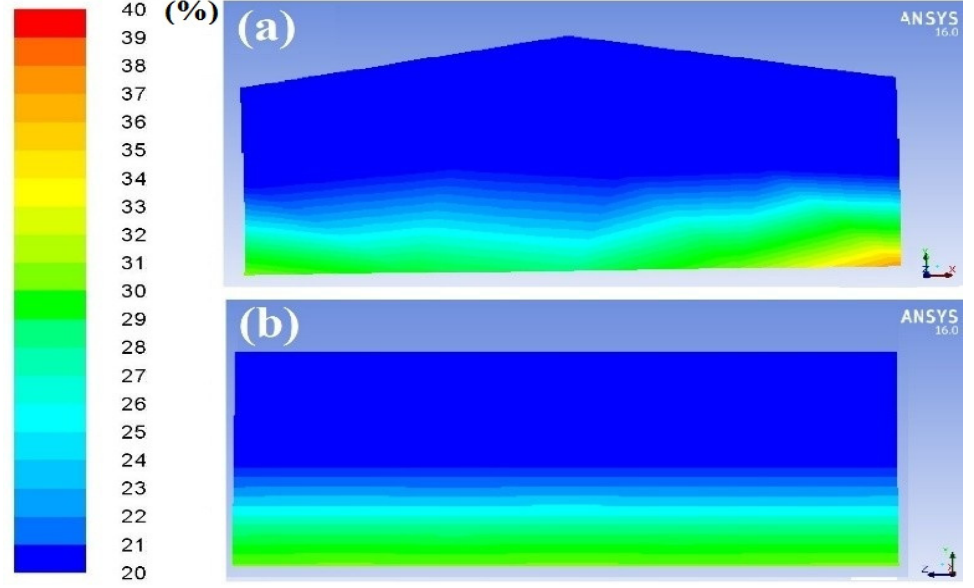
Figure 12. Relative air humidity contour (%) at the center of the greenhouse: vertical section ( a ) and horizontal section ( b ) at noon.